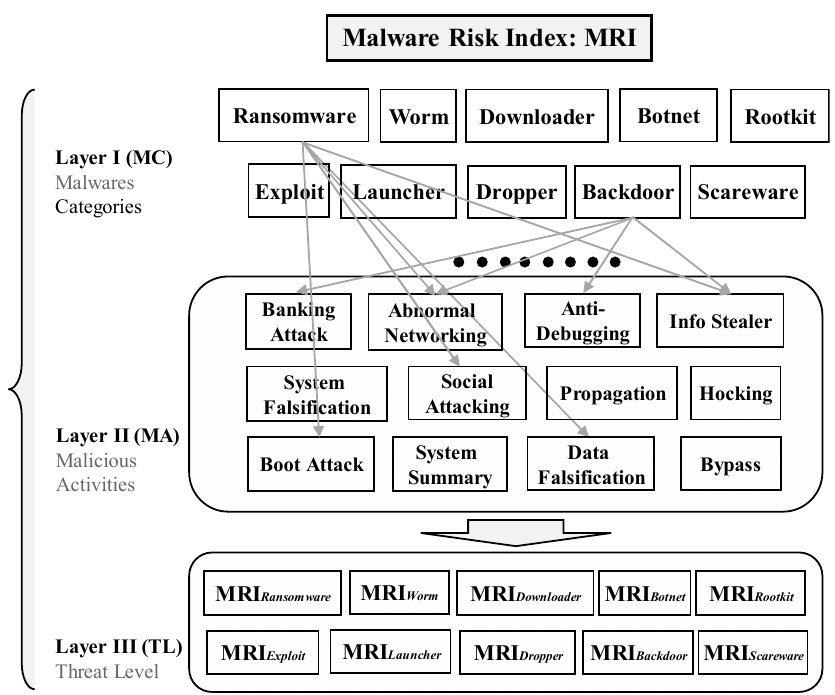
Figure 1. Analytic hierarchy process structure for estimating the malware risk index (MRI).